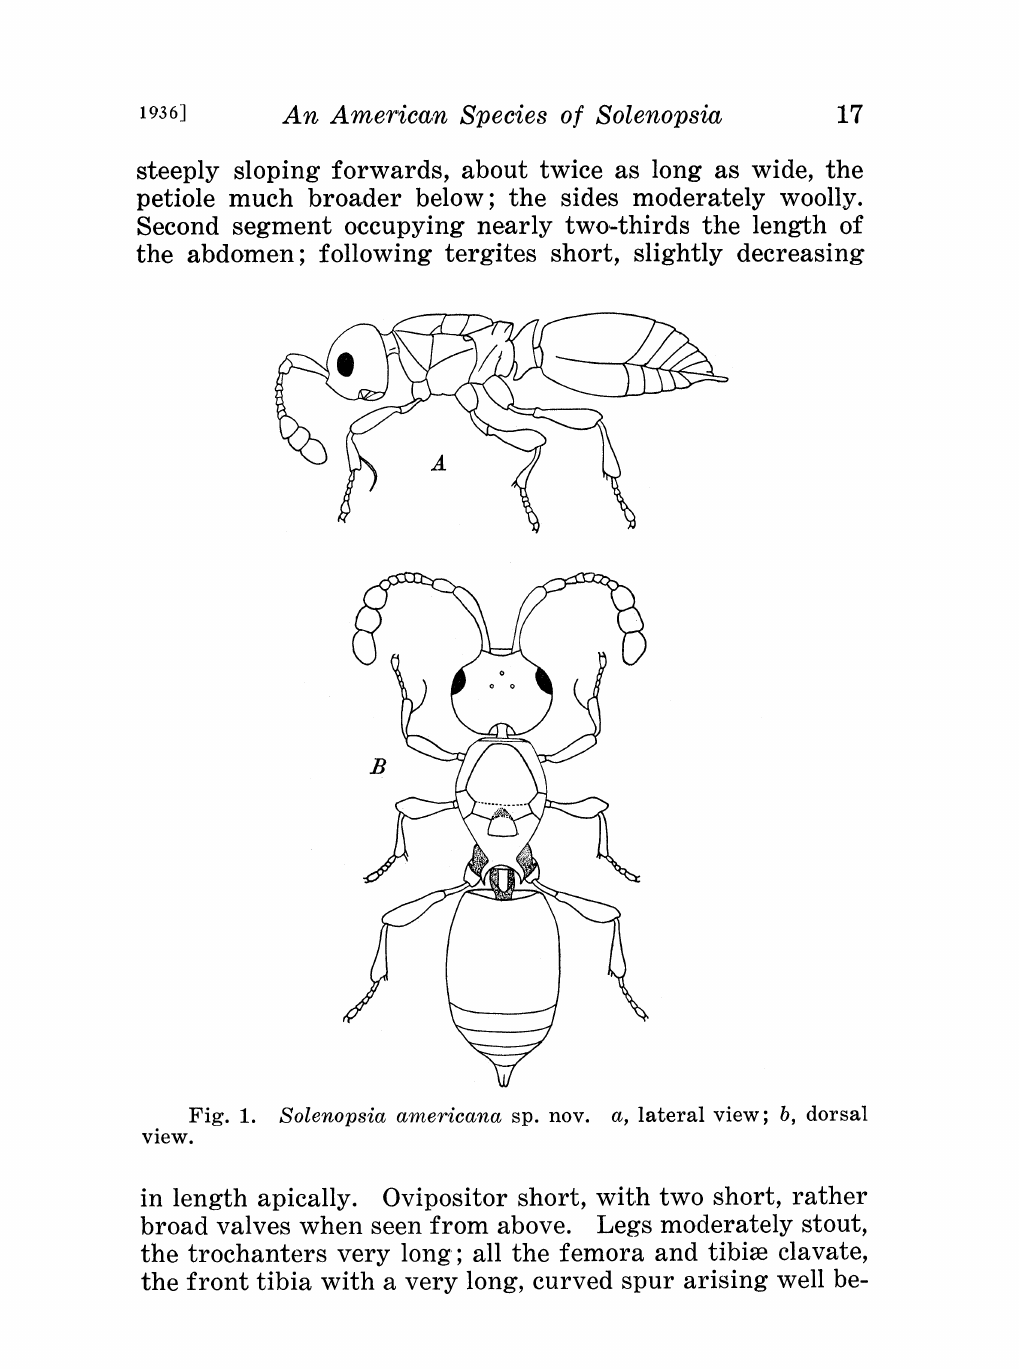
Solenopsia americana sp. nov. a, lateral view; b, Fig. 1. view.